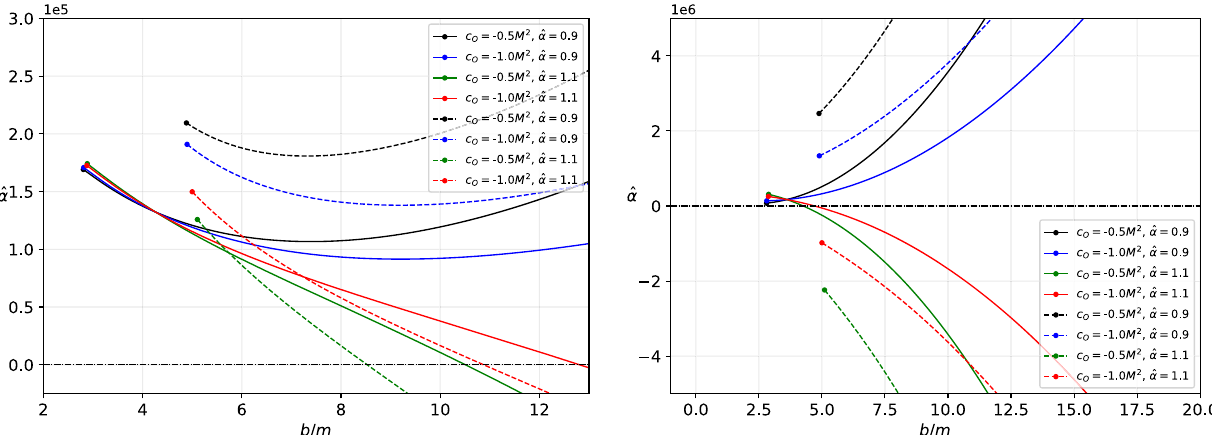
Fig. 8 Weak deflection angle of photons as a function of b / m for var- ious values of the spin and symmergent parameters. The solid lines correspond to a > 0 (prograde) and dashed lines correspond to a < 0